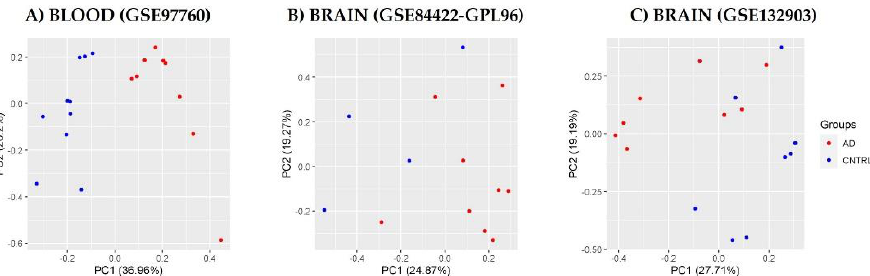
Figure 3. Principal component analysis (PCA) of processed data (CNTL and AD). Data of ( A ) blood database GSE97760, ( B ) brain database GSE84422-GPL96, and ( C ) brain database GSE132903.